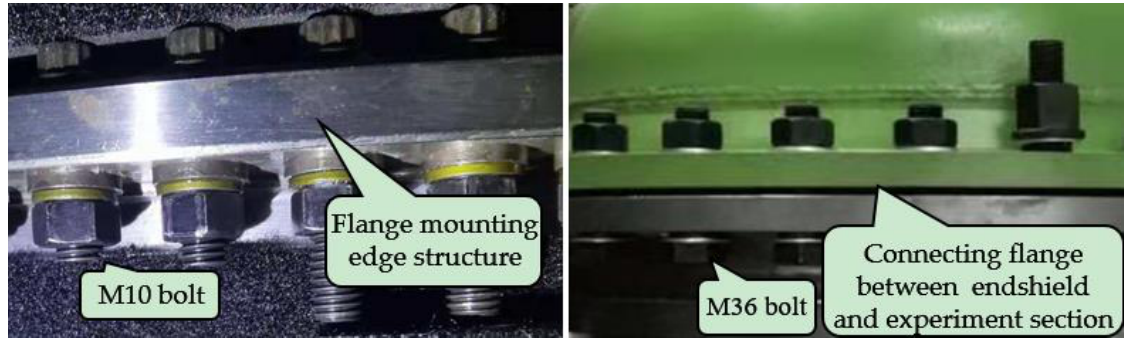
Figure 7. Physical map of the flange connection installation for the experimental bench.